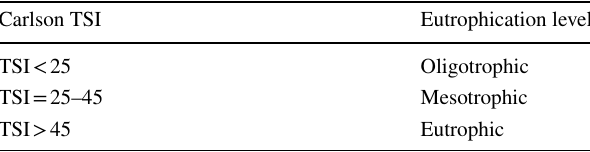
Table 1 Eutrophication level according to Carlson index (TSI) Carlson TSI